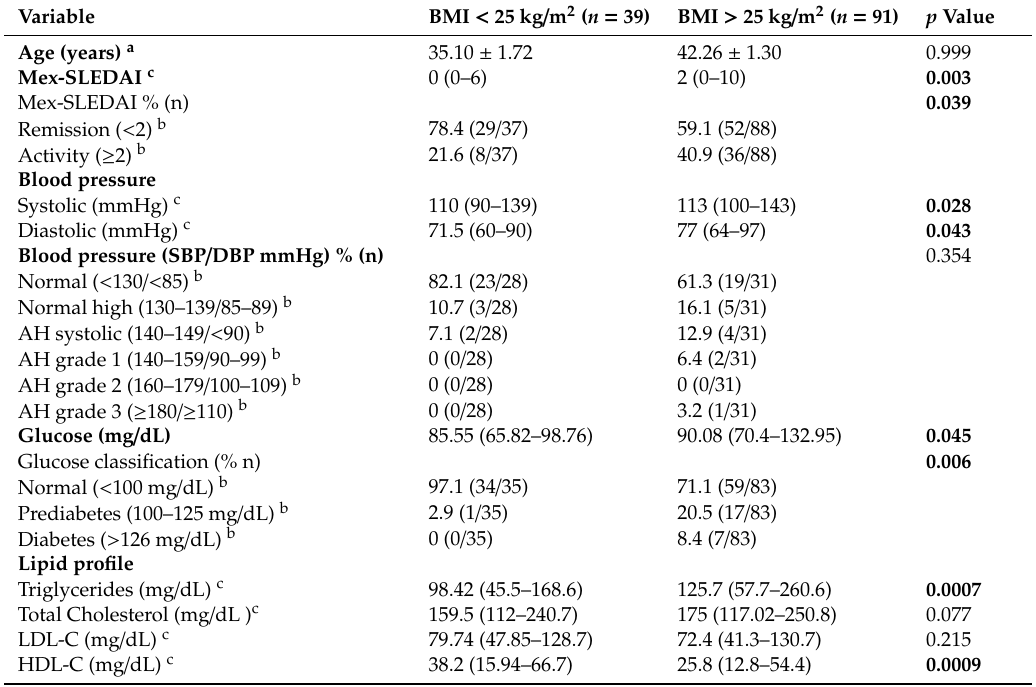
Table 2. Clinical and biochemical characteristics of the systemic lupus erythematosus stratified according to the body mass index